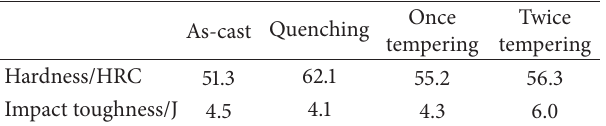
Table 2: Hardness and impact toughness of specimen. Once Twice As-cast Quenching tempering tempering Hardness/HRC 51.3 62.1 55.2 56.3 Impact toughness/J 4.5